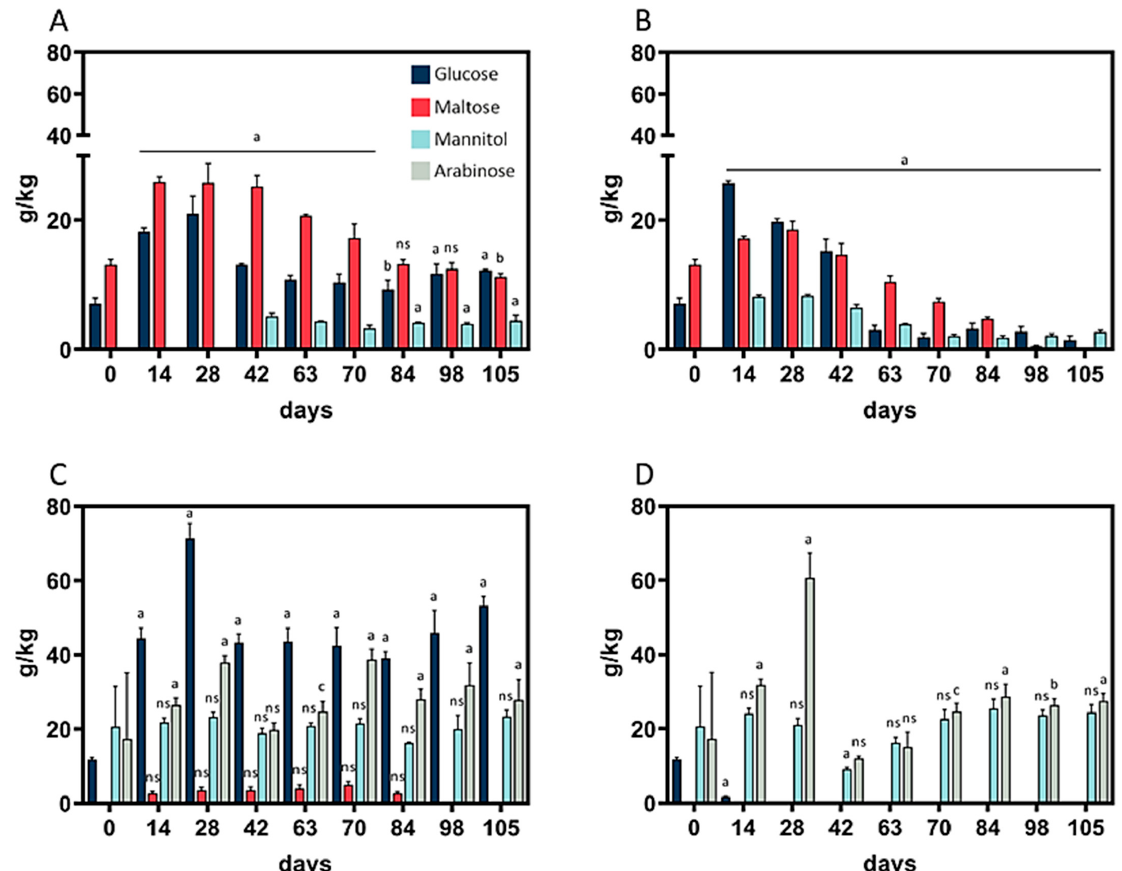
Figure 3. Arabinose, glucose, maltose, and mannitol contents of sourdough . ( A ) Wheat sourdough; 4 °C; W700. ( B ) Wheat sourdough; 10 °C; W700. ( C ) Rye sourdough; 4 °C; R960. ( D ) Rye sourdough; 10 °C; R960.